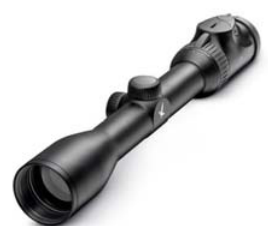
Figure 9 – Swarovski 1.7- 10x42 L optical sight (Swarovski Optik, 2018) Рис . 9 – Оптический прицел Swarovski 1.7- 10x42 L (Swarovski Optik, 2018) Слика 9 – Оптички нишан Swarovski 1.7- 10x42 L (Swarovski Optik,